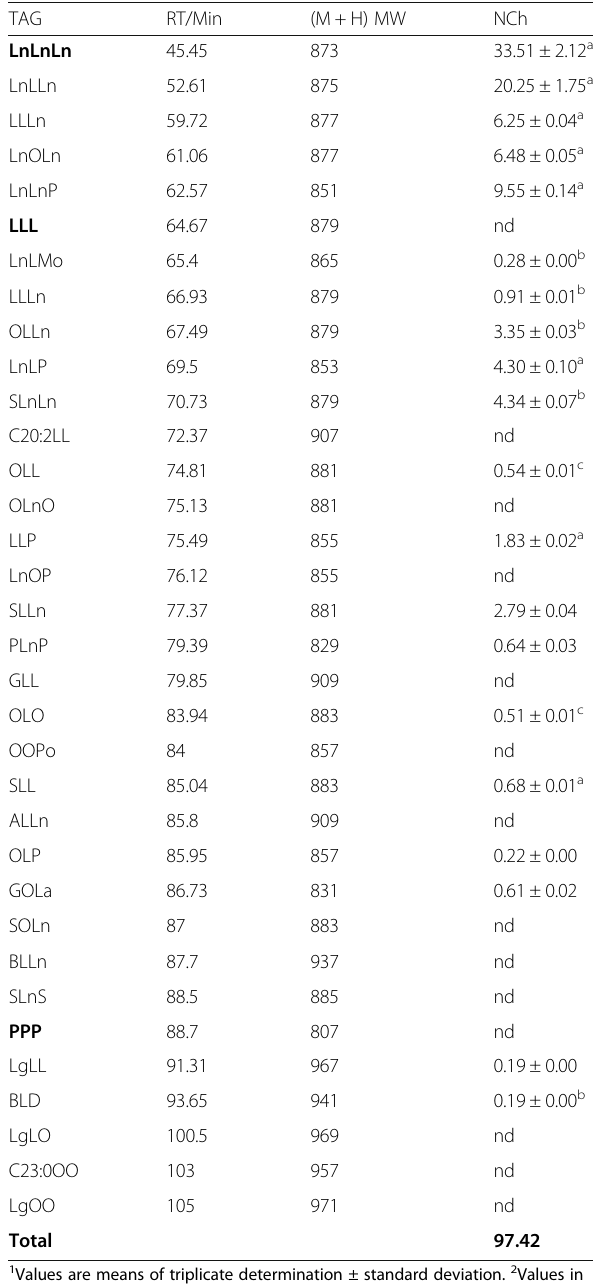
Table 2 Triacylglycerol (TAG) composition (relative concentration, %) of non-stripped chia seed oil 1,2,